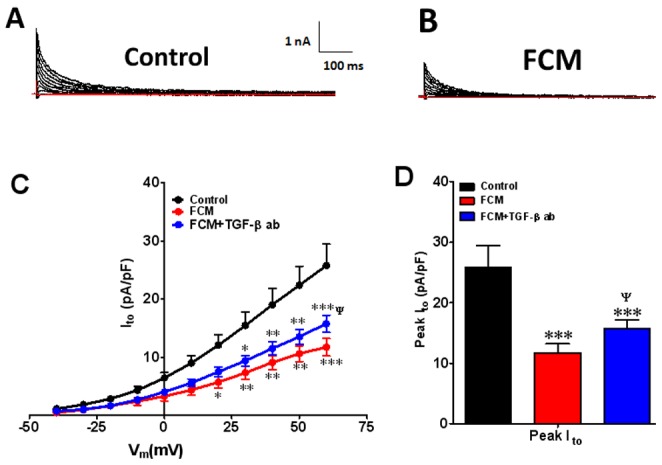
Effects of fibroblast conditioned medium (FCM) on outward potassium current (Ito) after 72 hr treatment.Representative current traces A) control, B) FCM. Ito IV relation at voltages between −40 and +60 mV for control (black), FCM (red) and FCM+TGF-β1 ab (blue) is shown in panel C. D) peak Ito under control conditions. Values are mean ± standard error of the mean. N = 10 cells from 5 different isolations. *indicates p<0.05, **indicates p<0.01, ***indicates p<0.001 significant difference between control and FCM treated cells. Δ indicates p<0.05 significant difference between FCM+TGF-β1 ab and FCM treated cells.